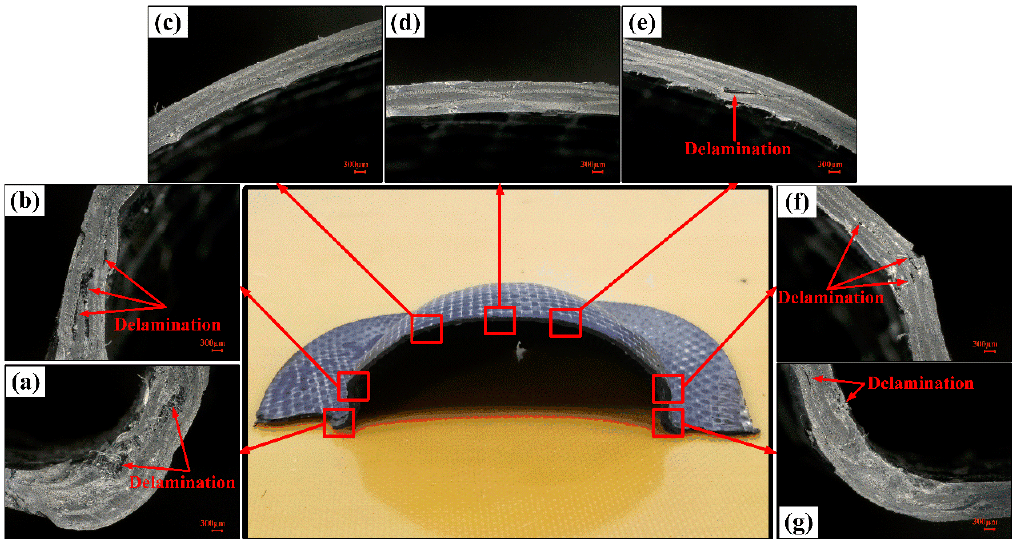
Figure 12. Cross-section of the fracture specimen of the Erichsen test under the conditions of 325 °C (IE = 32 mm).